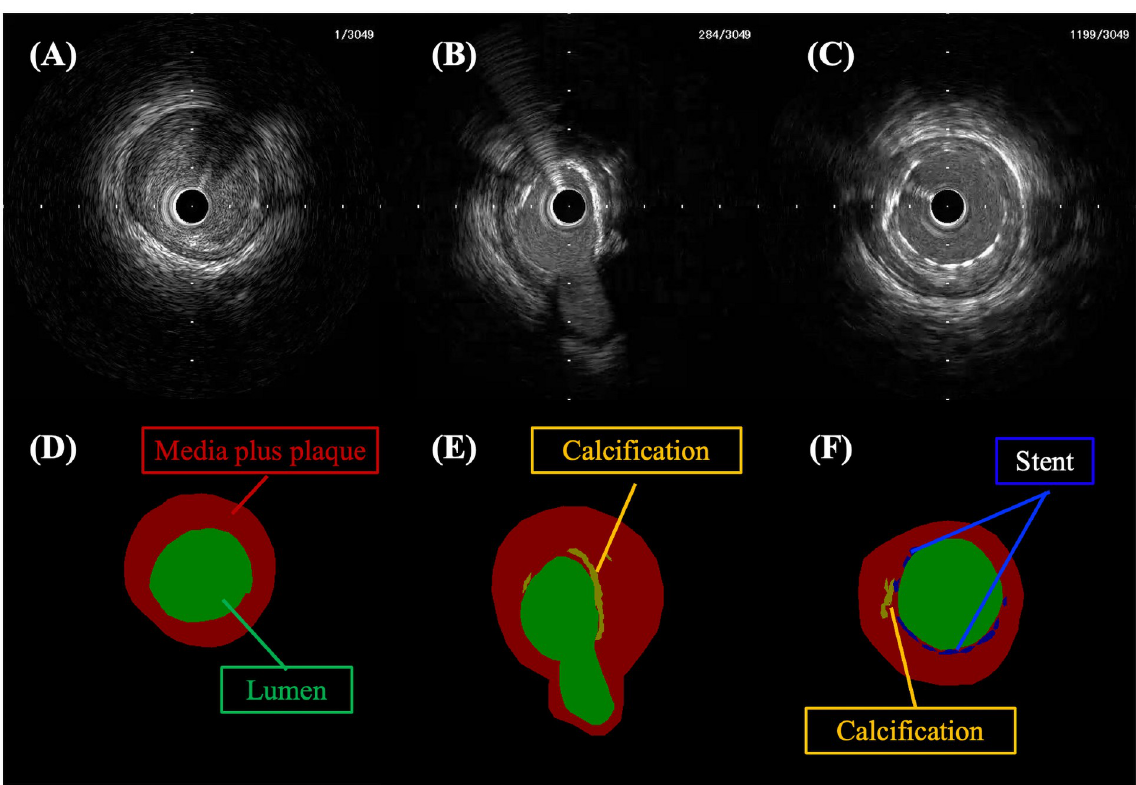
Fig 1. Representative manually segmented IVUS images and mask images. Upper images show IVUS images and lower images show mask images. Panel D is the mask image segmented from panel A. Similarly, panel E corresponds to panel B and panel F corresponds to panel C. The green, red, orange, and blue areas denote the lumen area, the medial plus plaque area, calcification, and a stent, respectively. The black areas show